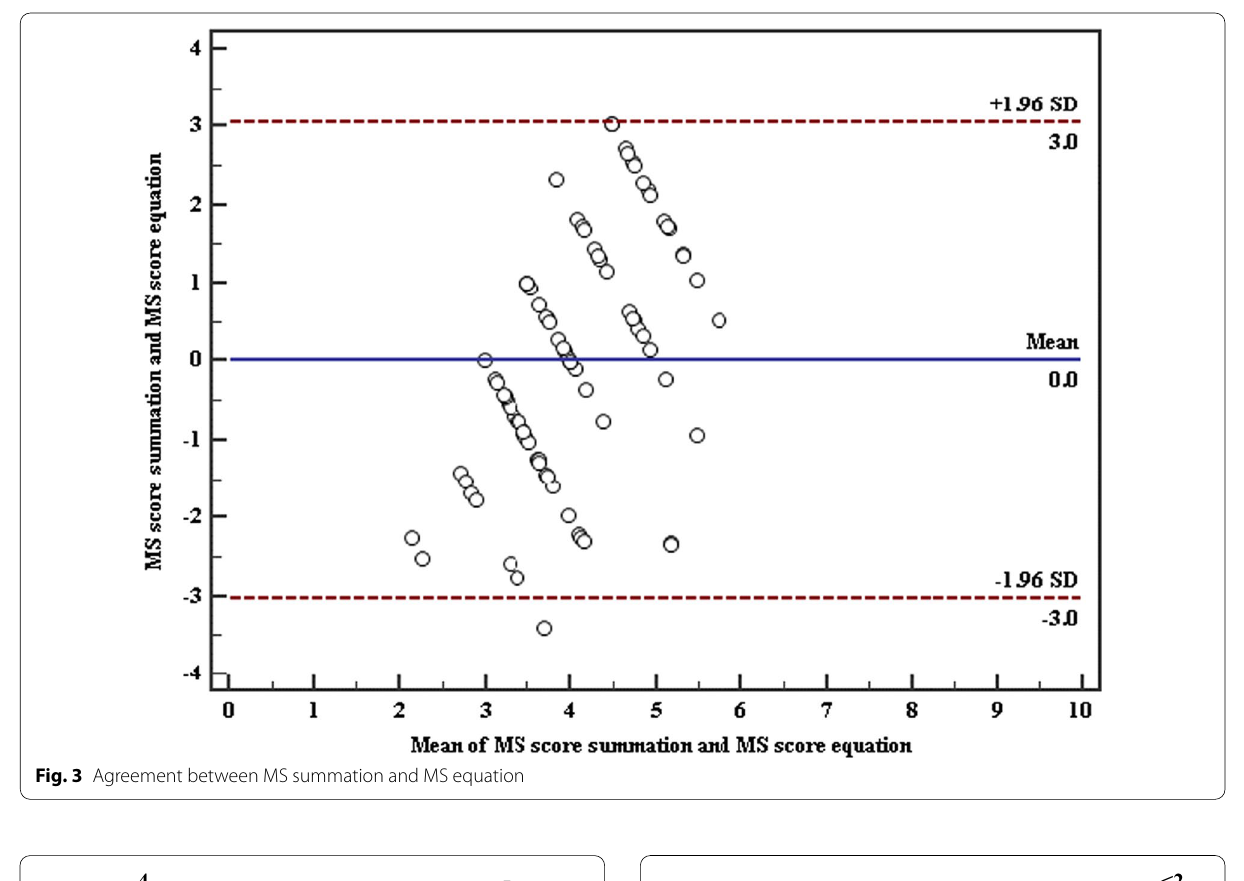
Fig. 3 Agreement between MS summation and MS equation